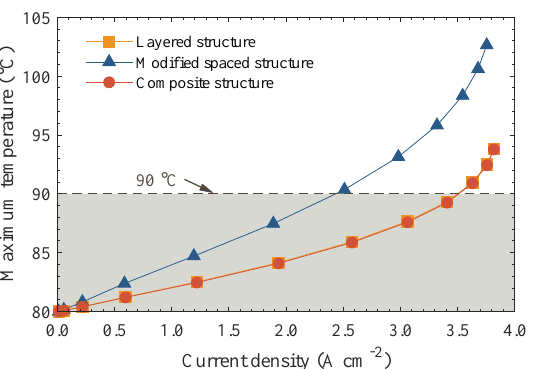
Figure 7. Comparison of the maximum temperatures of PEMFCs cooled by HPBPs with different internal structures.